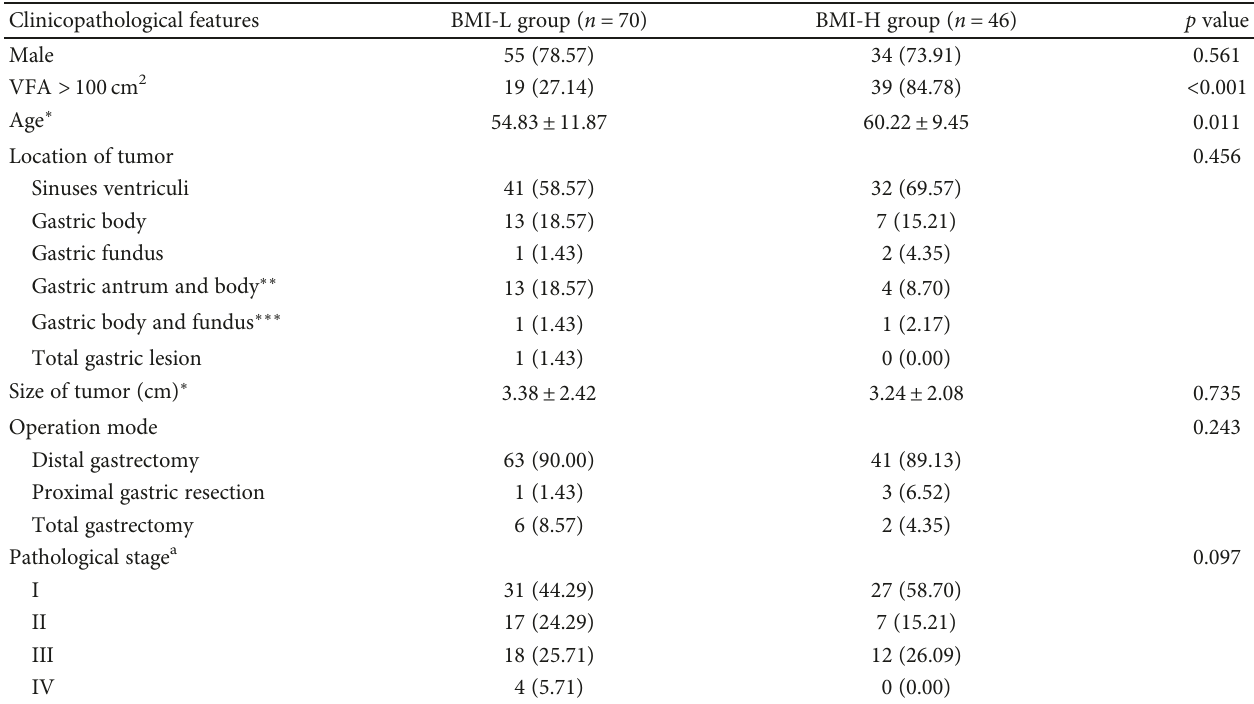
Table 2: Comparison of features between the low-BMI group and high-BMI group (cases (%)). Clinicopathological